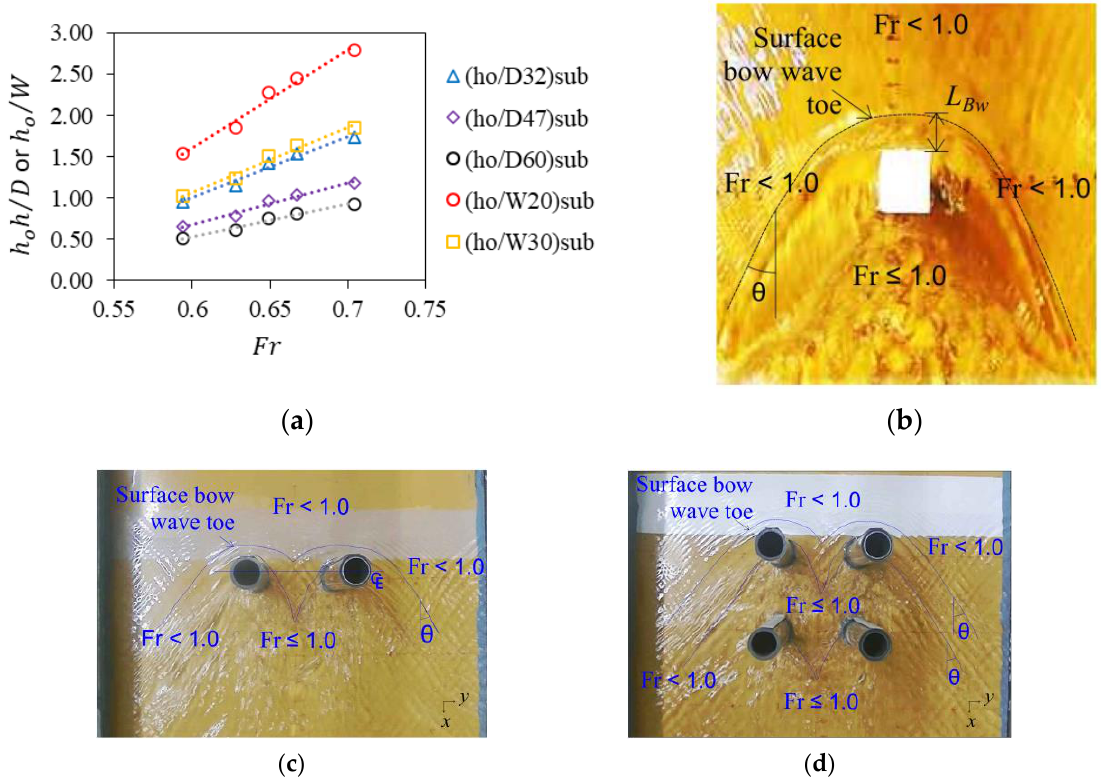
Figure 2. Flow forms with non - dimensional water depth relative to the cylinder geometry and the formation of the surface bow - wave around an impervious emergent cylinder in the subcritical open - channel flow: ( a ) flow forms for case C1 and surface bow - wave formation ( b ) for case C1 - RC, ( c ) for case C2 - 1, and ( d ) for case C4 - 1. The numbers after 𝐷 and 𝑊 indicate the diameter and width, respectively. The subscript “sub” means “subcritical”.